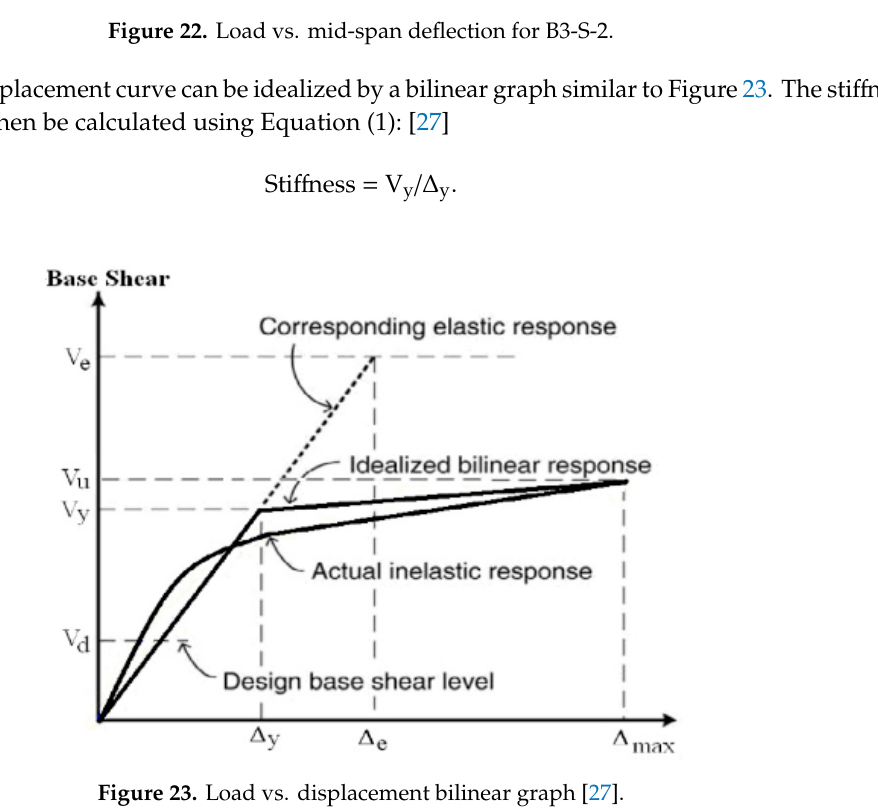
Figure 22. Load vs. mid-span deflection for B3-S-2.